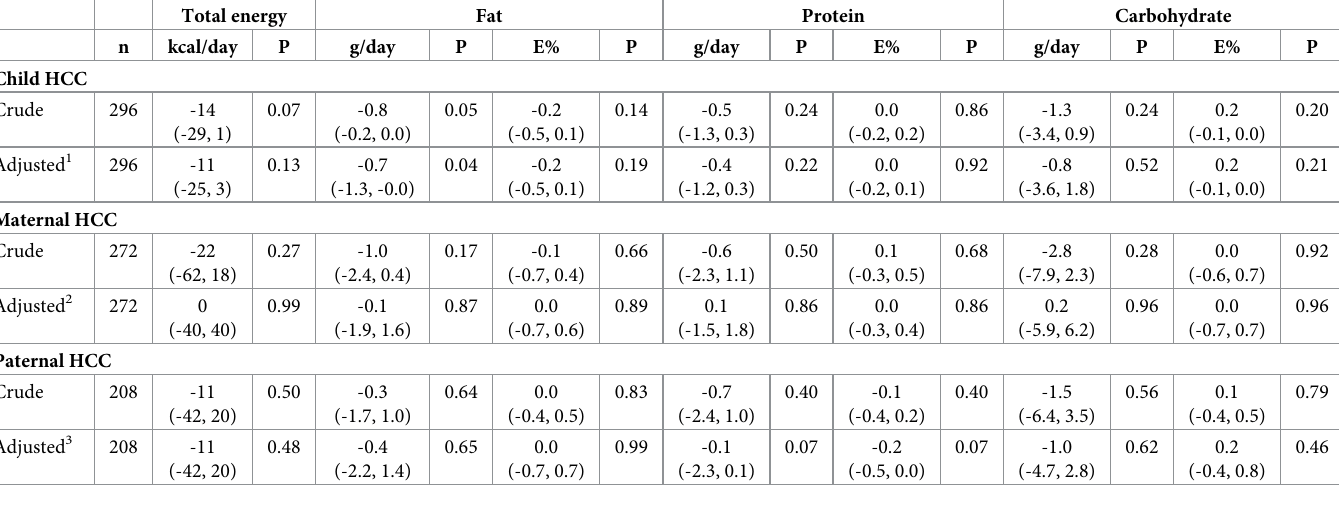
Table 2. Association between child and parental hair cortisol concentration (units of 100 pg/mg) and macronutrient intake among children in the Healthy Start